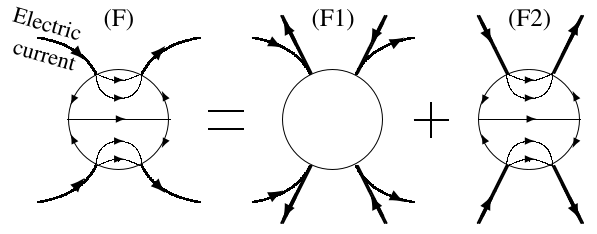
Fig. 6. Curvature effect in Fukushima’s theorem (after Fukushima, 1985b).